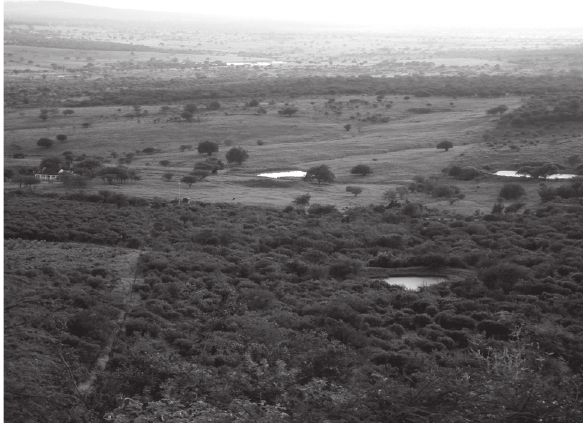
Figure 2. Typical landscape found in the study area, with open caatinga vegetation and open fields used for pasture and agricul-